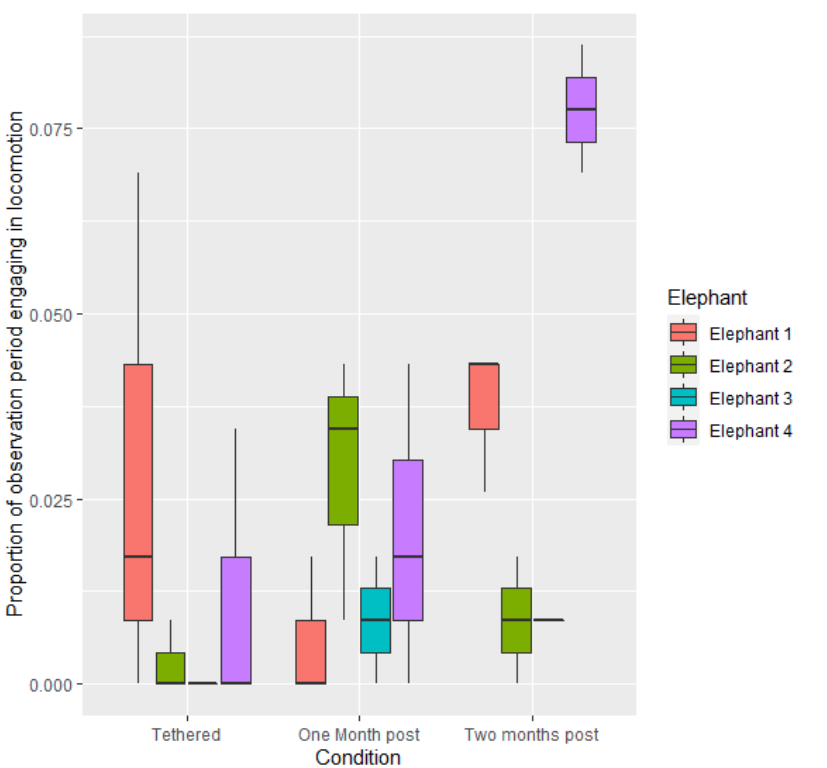
Figure 4. Mean proportion of time spent engaging in locomotion per observational period during the three conditions. Animals 2022 , 12 , x FOR PEER REVIEW Proportion of time engaging in feeding, maintenance and standing behaviour did not differ significantly in frequency between the tethered and non-tethered conditions ( p > 0.05) or across the three time periods ( p > 0.05). No differences were observed between individuals ( p > 0.05). Negative social interactions were not modelled due to low occur- rence. Negative social interactions were only observed during two scans of one individual (E3) during one evening in condition 3; two months post-release from tethers. Proportion of time spent engaging in ARBs did not significantly differ when elephants were tethered or not tethered, between the three time periods or between individuals ( p > 0.05). How- ever, although not statistically significant, it is noted that reductions were seen in perfor- mance of ARBs, across all elephants, when elephants were no longer tethered (Figure 5).